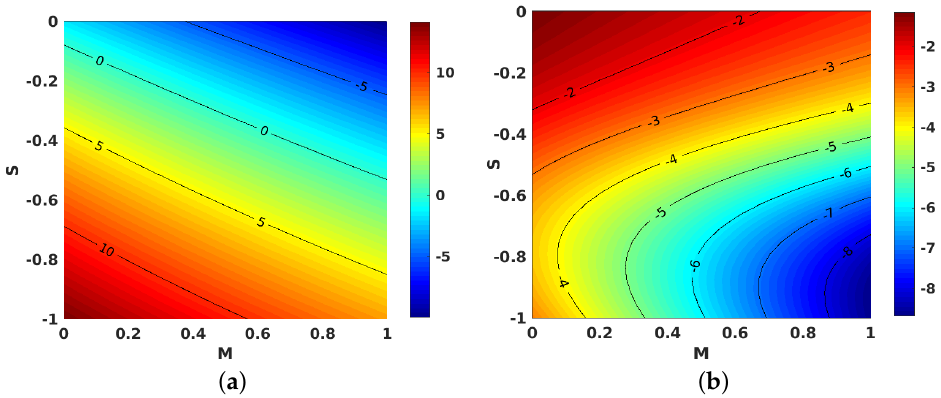
Figure 13. Effect of unsteadiness parameter ( S ) and magnetic parameter ( M ) on θ (cid:48) ( 1 ) . ( a ) Injection; ( b )